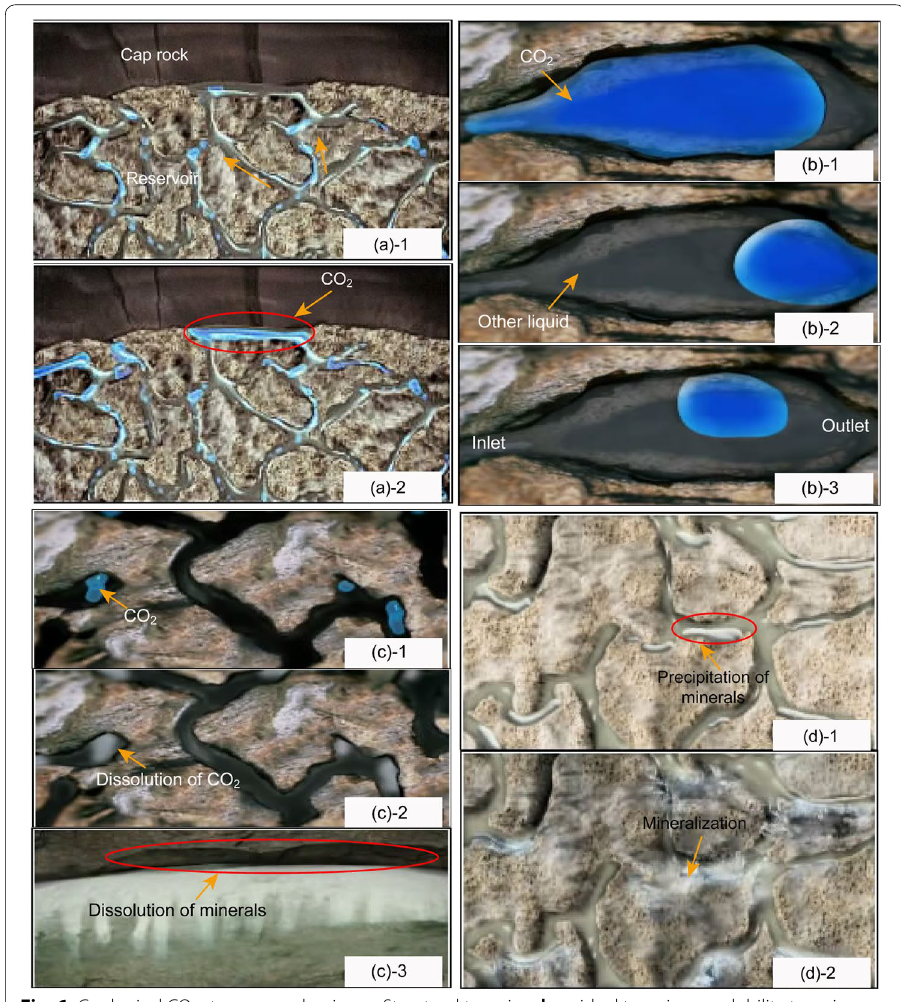
Fig. 6 Geological CO 2 storage mechanism. a Structural trapping, b residual trapping, c solubility trapping, and d mineral